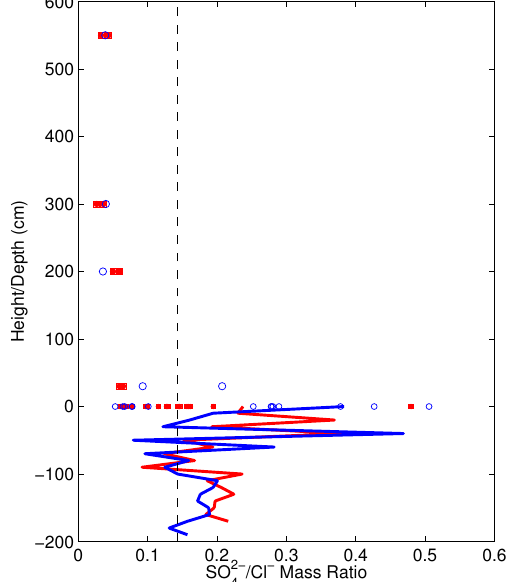
/ Cl − mass ratios for sea ice (negative heights), sur- Figure 4. SO 2 − 4 face snow (height of 0), and blowing snow (height above snow sur- face). Butter Point Site samples are shown in red filled-in squares (snow samples) and a red line (sea ice), while Iceberg Site samples are shown in blue open circles (snow samples) and a blue line (sea / Cl − mass ratio is shown as a black ice). The standard ocean SO 2 − 4 dashed line (Morris and Riley,